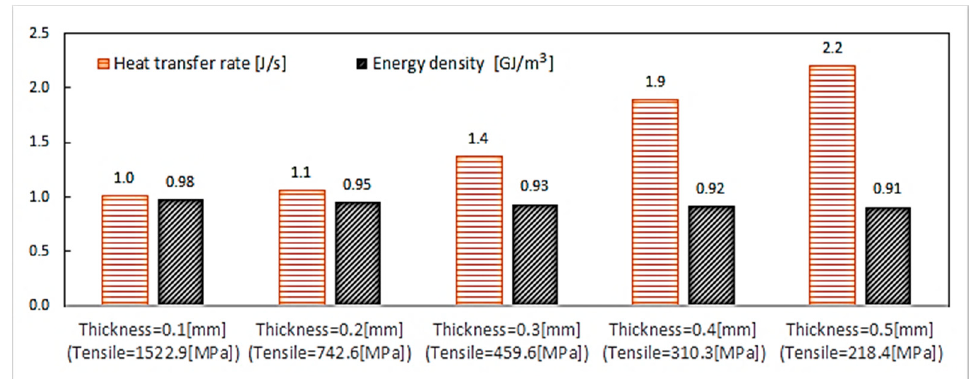
Figure 5. Heat storage rate, energy density of iron shell, using different EPCM dimensions.